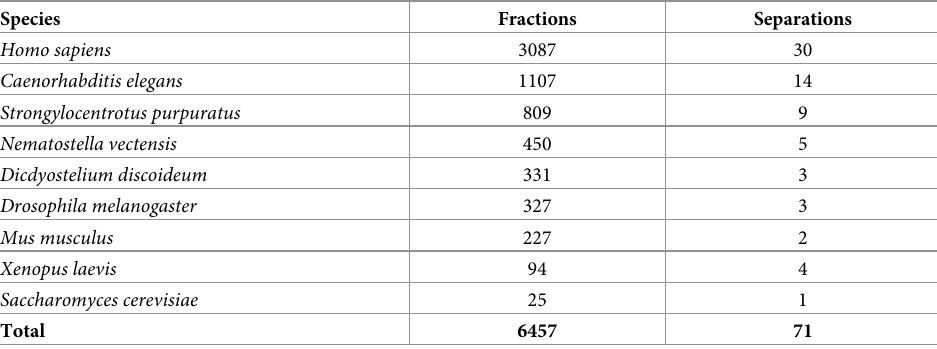
Table 1. Experimental co-elution mass spectrometry data used for analyses, from Wan et al . 2015. Species